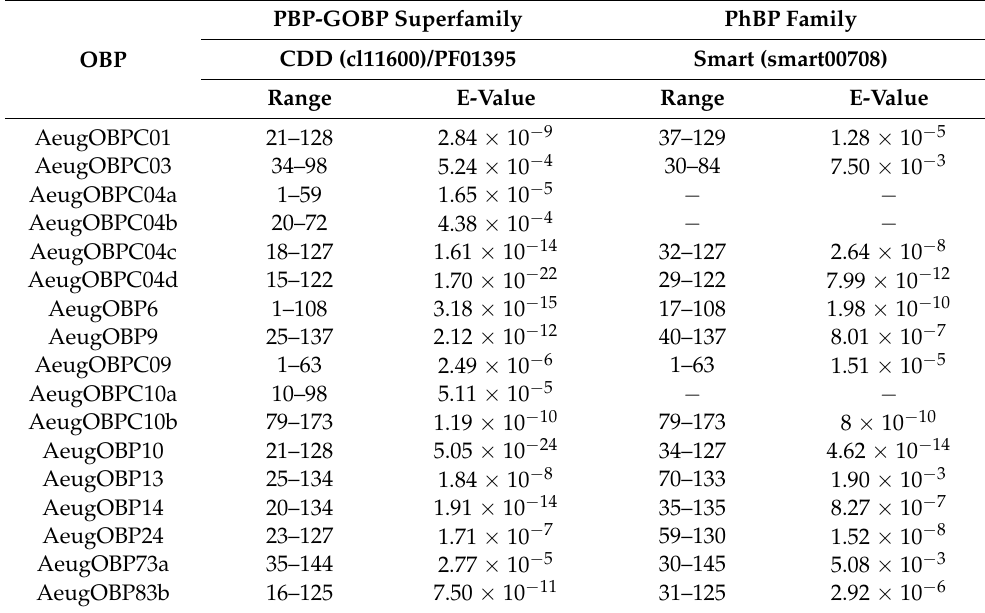
Table 1. Functional annotation of AeugOBPs, based on CDD/SPARCLE